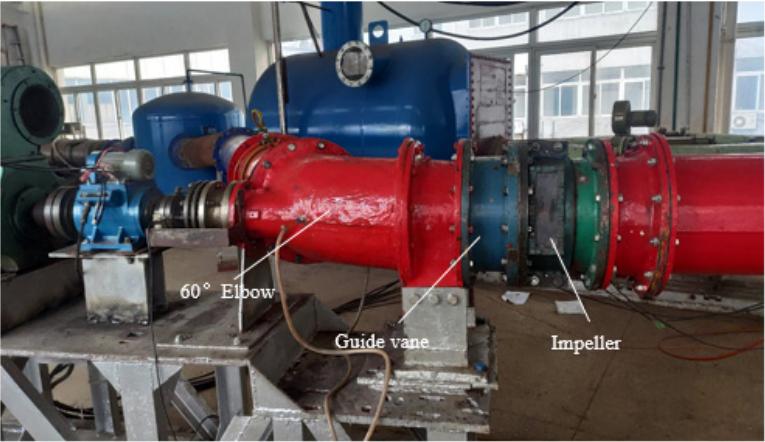
Figure 4. Schematic diagram of the experimental pump section after installation and splicing.